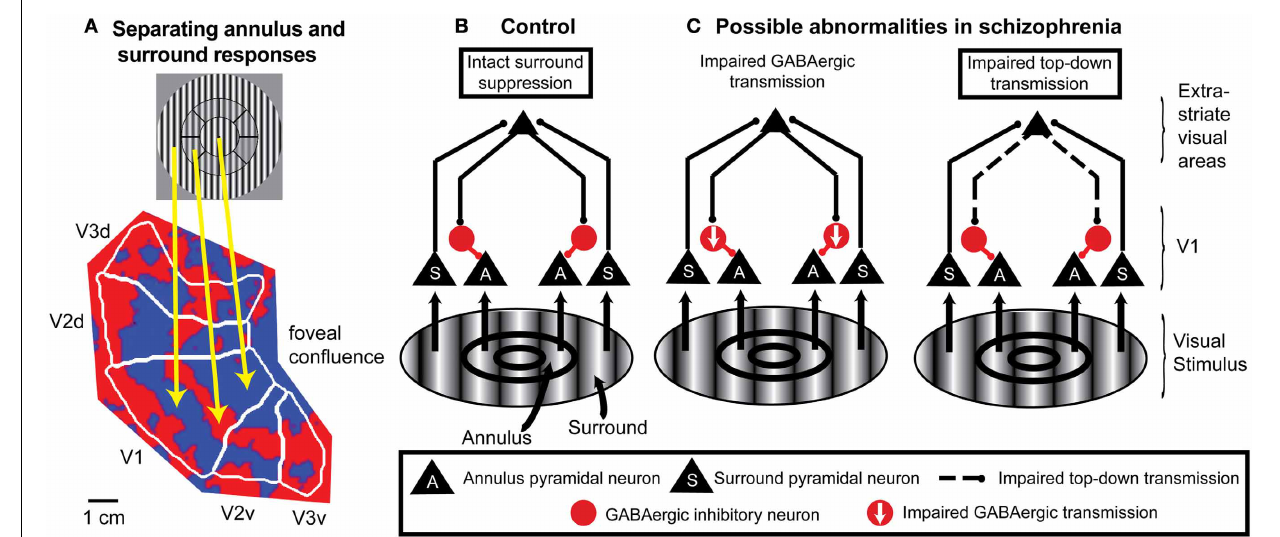
FIGURE 3 | An example of application of fMRI and a spatial attention paradigm to study impaired neural mechanisms of surround suppression in schizophrenia. (A) Functional MRI data displayed on a flattened occipital cortical surface from an example subject. The circular grating stimulus is divided into two regions: the annulus and the “surround” (in this example, the “surround” includes visual field locations both inside and outside the annulus). An annulus was used as the “center” stimulus instead of a central circle or patch because it is difficult to definitively map retinotopic early visual cortical areas with fMRI for locations close to the fovea (central vision; where the gaze is directed). In these localizer data, subjects viewed the annulus stimulus in block alternation with the surround stimulus. The fact that early visual cortical areas (in this example, V1, V2, and V3) contain retinotopic maps of the visual field means that the responses to the annulus and surround portions of the stimulus are spatially separated on the cortical surface. Red indicates regions that exhibited a stronger response to the annulus than to the surround, and blue indicates regions that responded more to the surround than to the annulus. The foveal confluence